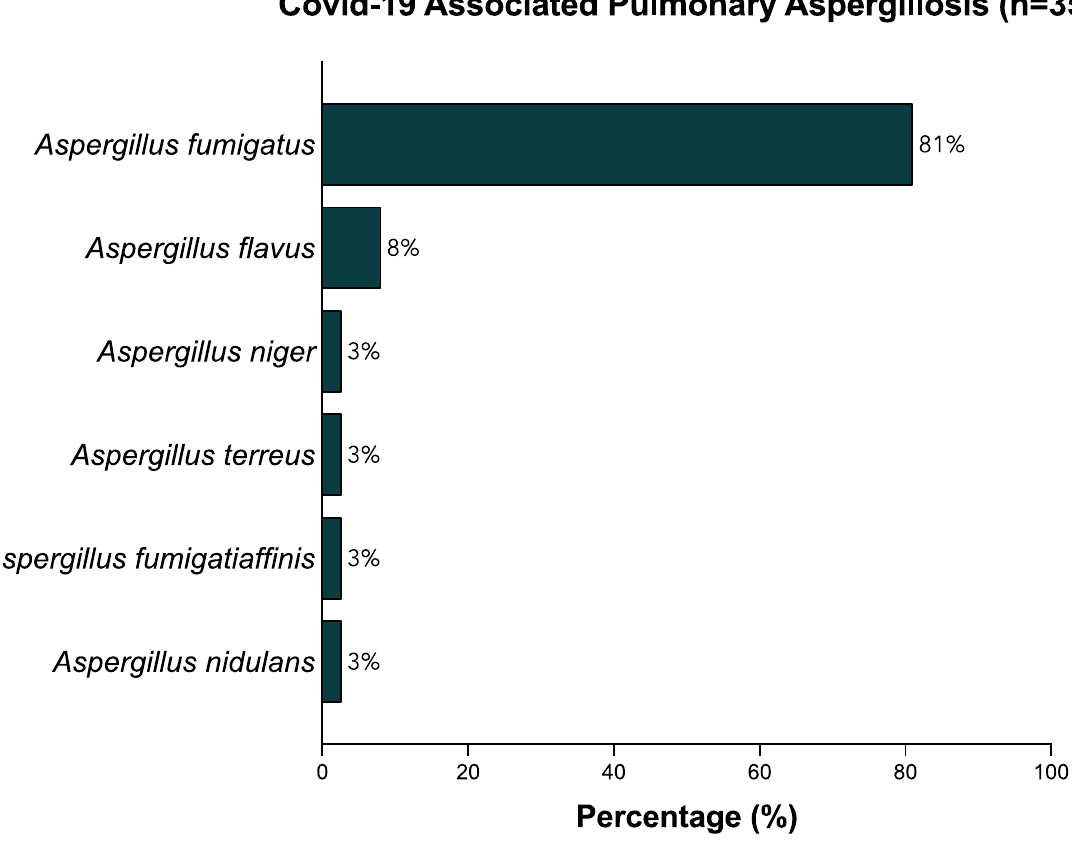
Figure 2. Survival probabilities of patients with and without putative aspergillosis in days after ICU admission ( A ) and mean time to first positive Aspergillus culture from BAL sample ( B ). Dotted lines represent mean time to infection.